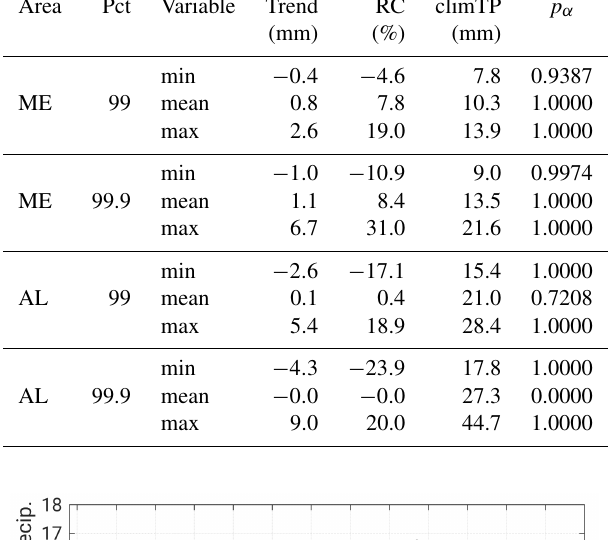
Table 3. Overall trend of daily spatial mean precipitation during TP1 and TP2 (1900–2028) using a linear regression of the yearly series of the 99th and 99.9th percentile (Pct; wet days only) for ME and AL. Given are absolute values and the relative changes (RCs) compared to the climatological mean (climTP; 1961–1990) for the ensemble minimum (min), the ensemble mean, and the ensemble maximum (max) percentile values within LAERTES-EU, and the related significance ( p value; α = 0 . 05). Area Pct Variable Trend